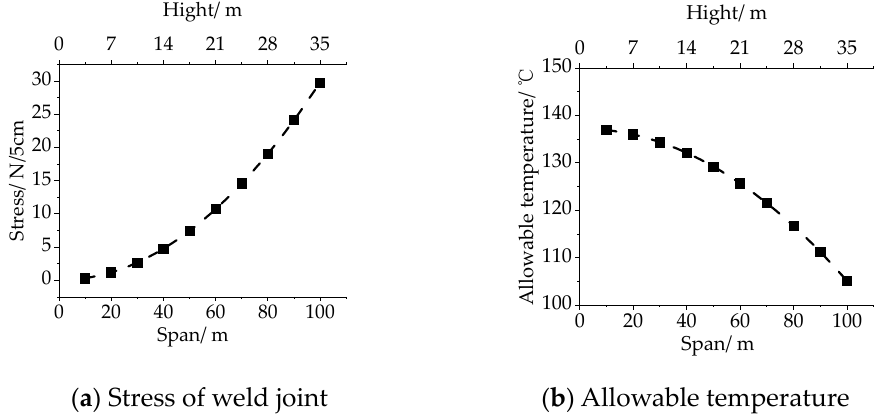
Figure 20. Stress and allowable temperature of center weld joint at different spans.